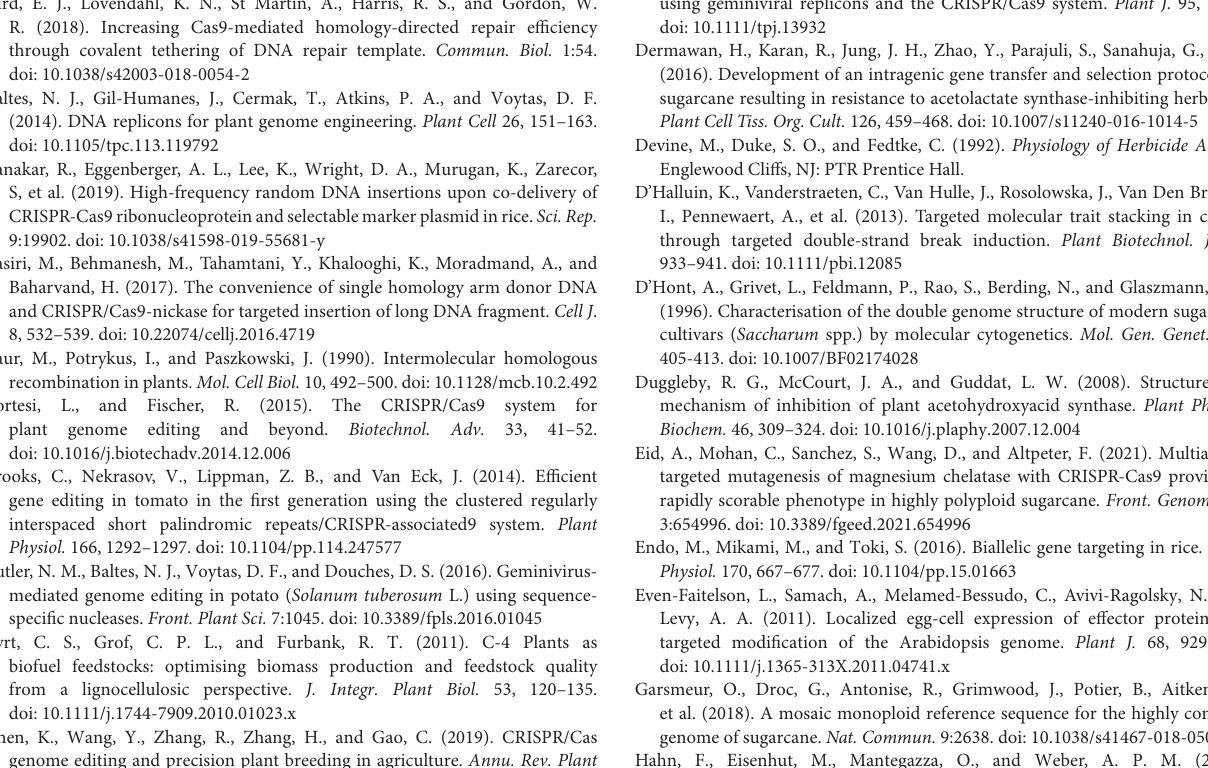
Supplementary Figure 2 | Sugarcane tissue culture, plant regeneration, and genetic transformation. (A) General outline of sugarcane tissue culture and genetic Supplementary Figure 3 | High-throughput TaqMan ® probe-based genotyping assay. (A) Schematic drawing of the TaqMan ® probe-based genotyping strategy to detect HDR events. Large PCR amplicons (1,913 bp) were generated with primers DO1 and UP6, the latter located outside of the template sequence to prevent amplification of randomly inserted templates. Fluorescent labeled TaqMan ® probes were designed to detect wild-type and mutant alleles